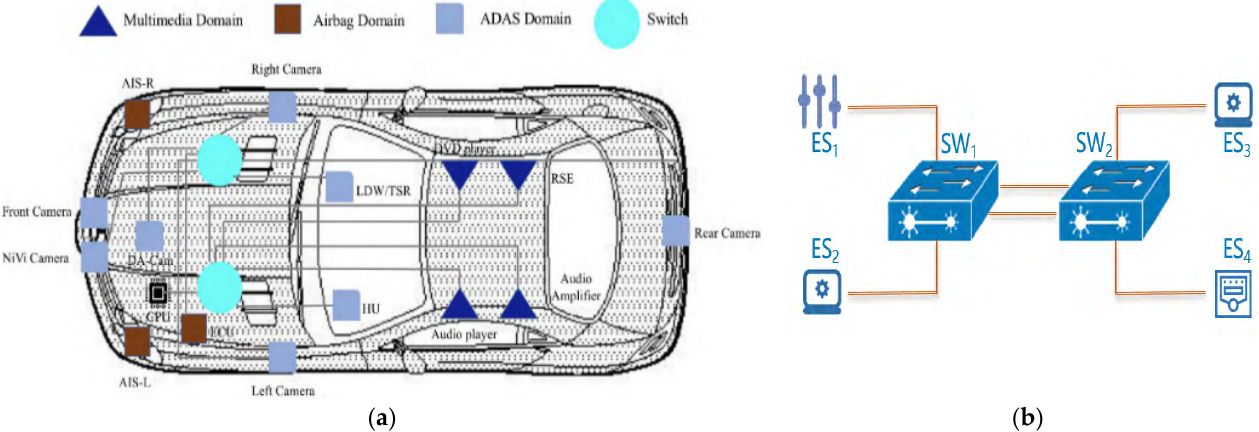
Figure 13 . Graphical model for the applied use case: ( a ) networking elements for a realistic vehicle use case and ( b ) repre- sentative networking model for the vehicle.